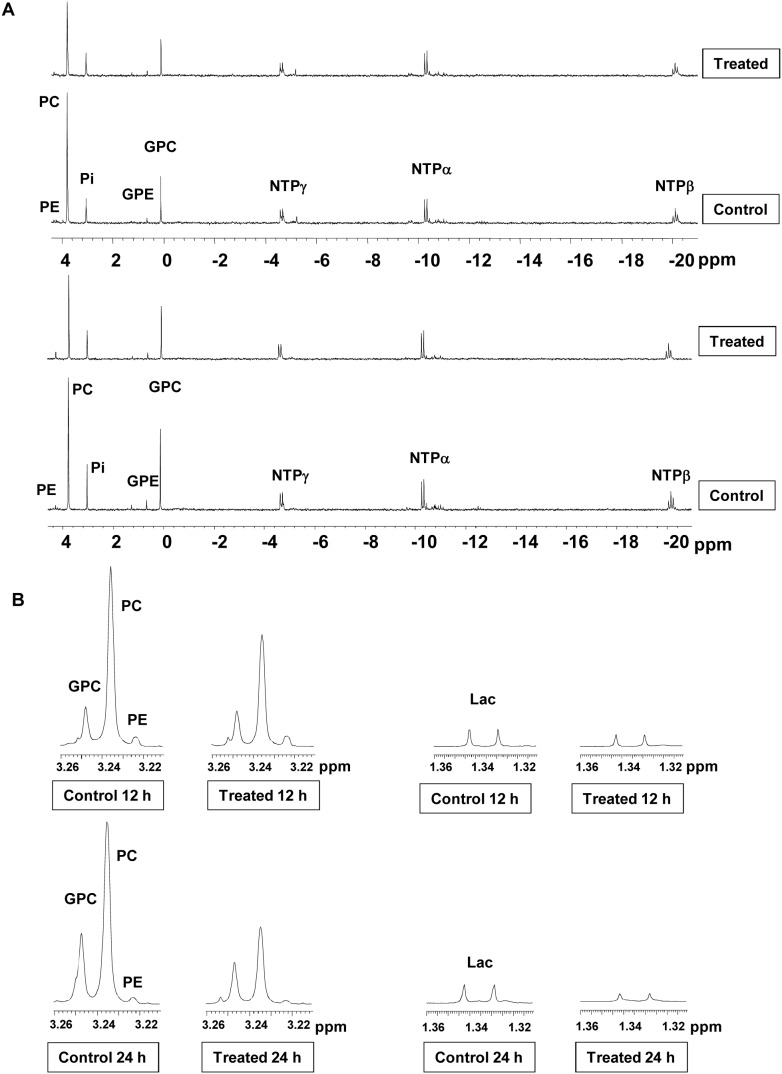
Metabolic changes following treatment of KNS42 pediatric glioblastoma cells with PI-103.Representative in vitro (A) 31P-NMR spectra and (B) expansion of 1H-NMR spectra regions representing choline–containing metabolites (left) or lactate (Lac; right) of KNS42 aqueous cell extracts following 12 or 24 hours treatment with PI-103 (5×GI50) compared to vehicle (DMSO) treated control.